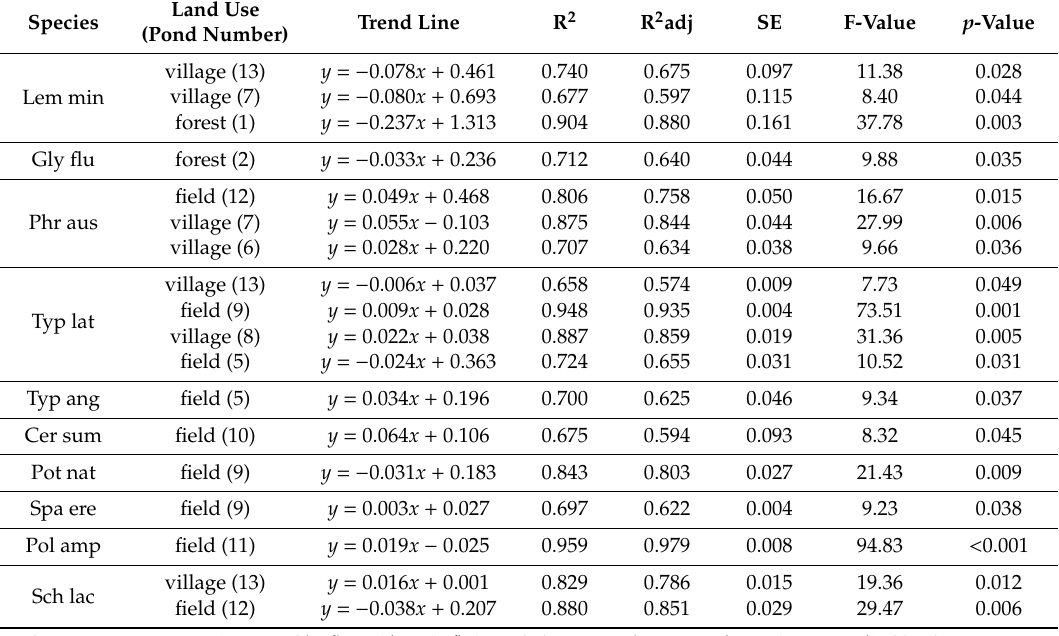
Table 6. Linear regression for species inhabiting the studied ponds during the research